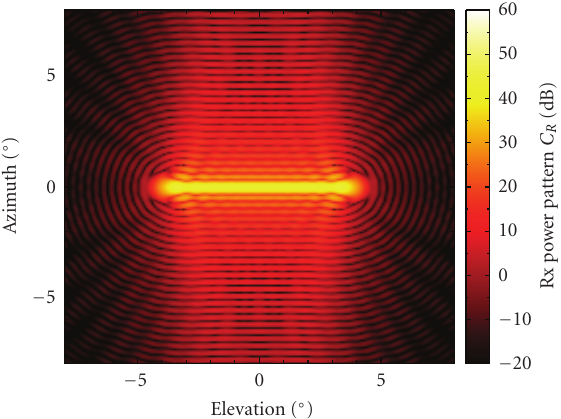
Figure 13: Reflector gain pattern versus ground range with one (solid), two (dotted) and four (dashed) feed elements activated.